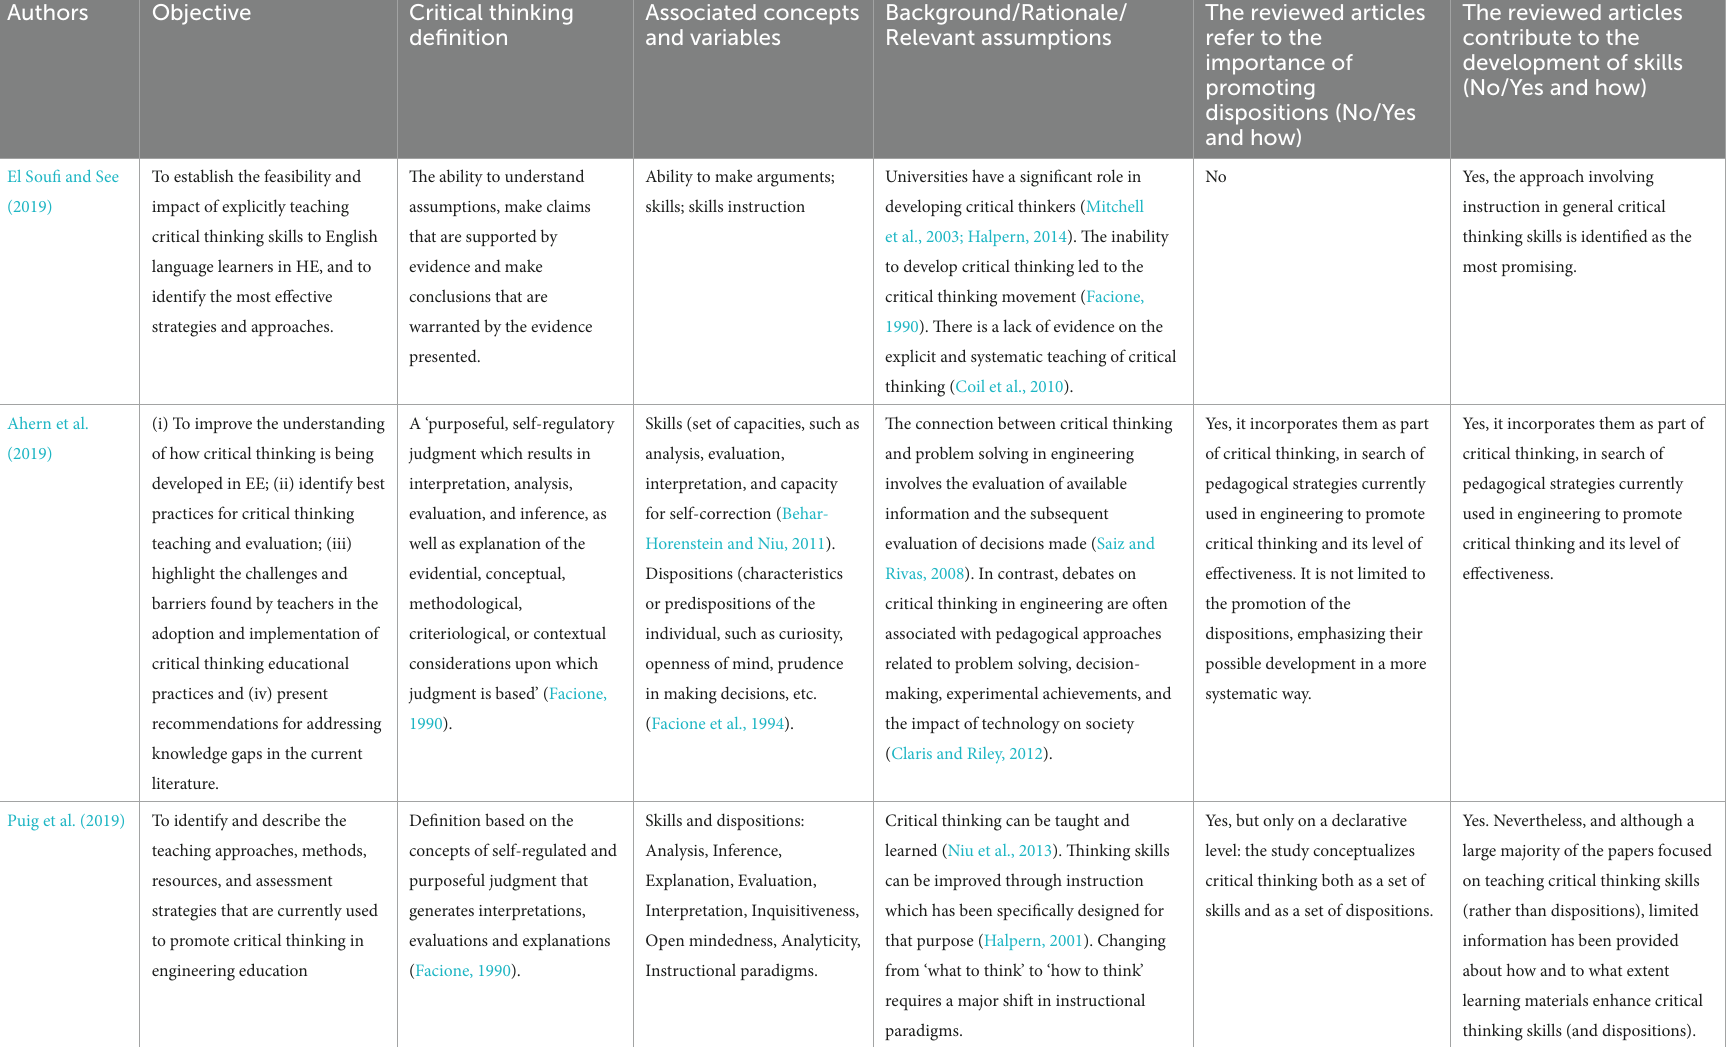
TABLE 4 Summary of the objectives, definition of critical thinking, associated concepts and vari-ables, assumptions, and relevant authors of each of the